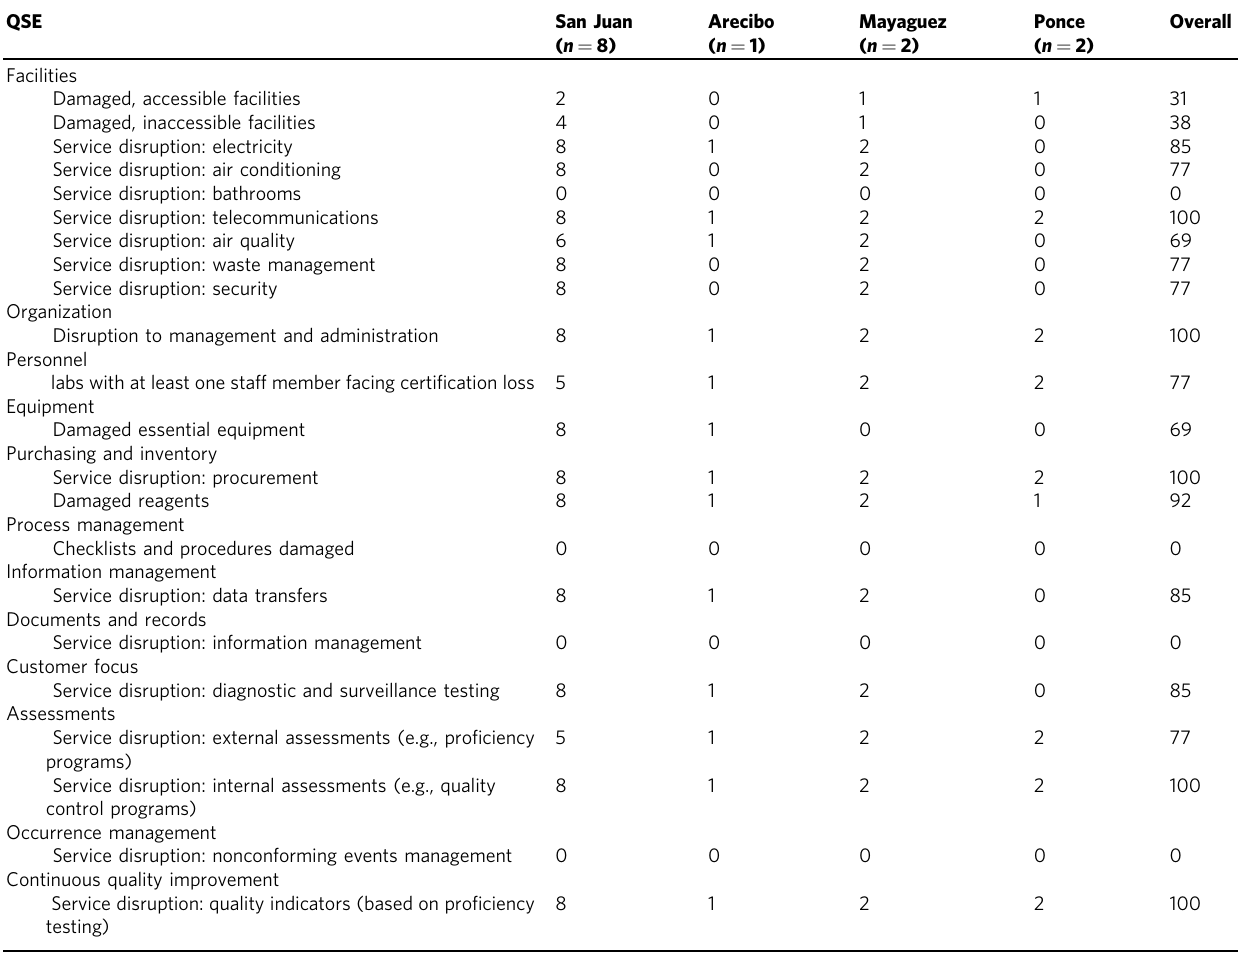
Table 1 Laboratory needs identi fi ed by initial assessments